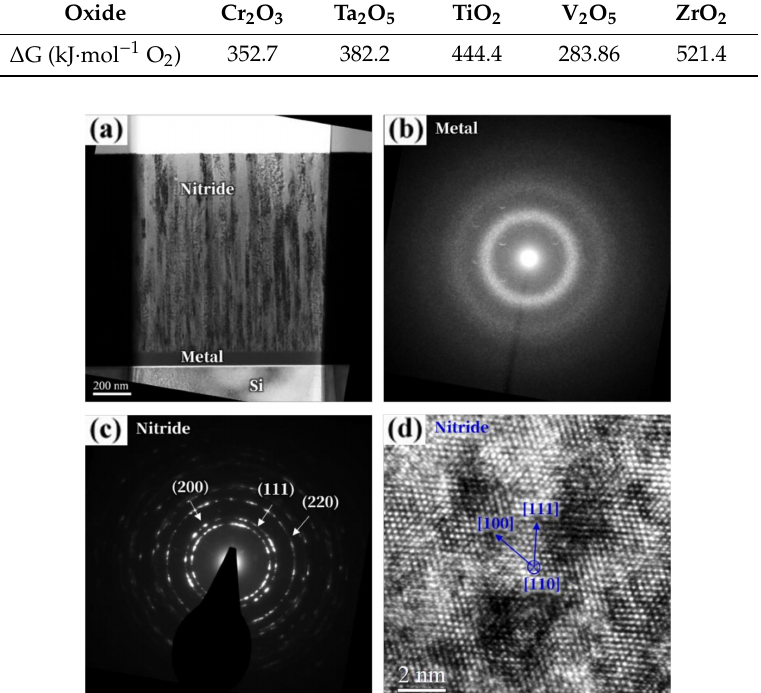
Table 1. Standard free energies of formation of oxides based on the target elements.